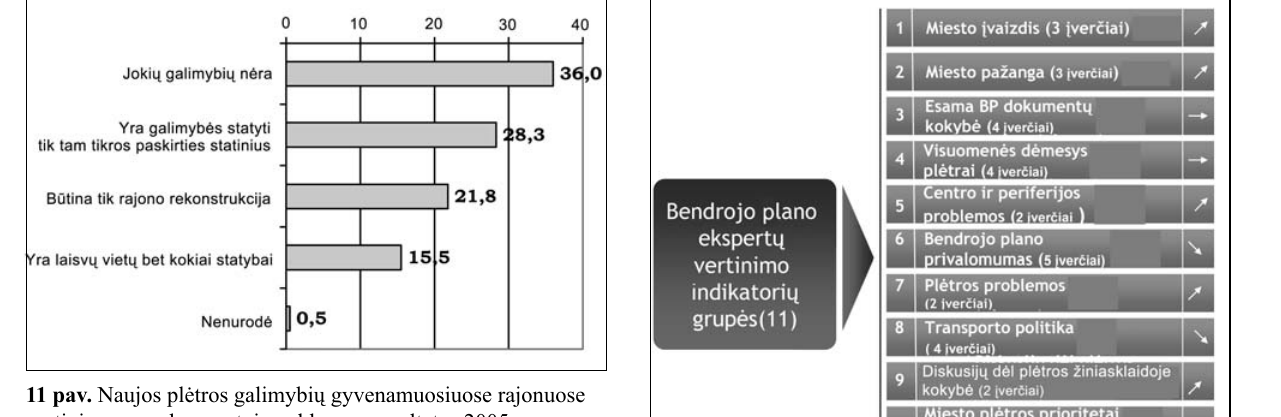
Fig 11. Assessment of new development possibilities in residential areas according to the citizens’ poll results, 2005